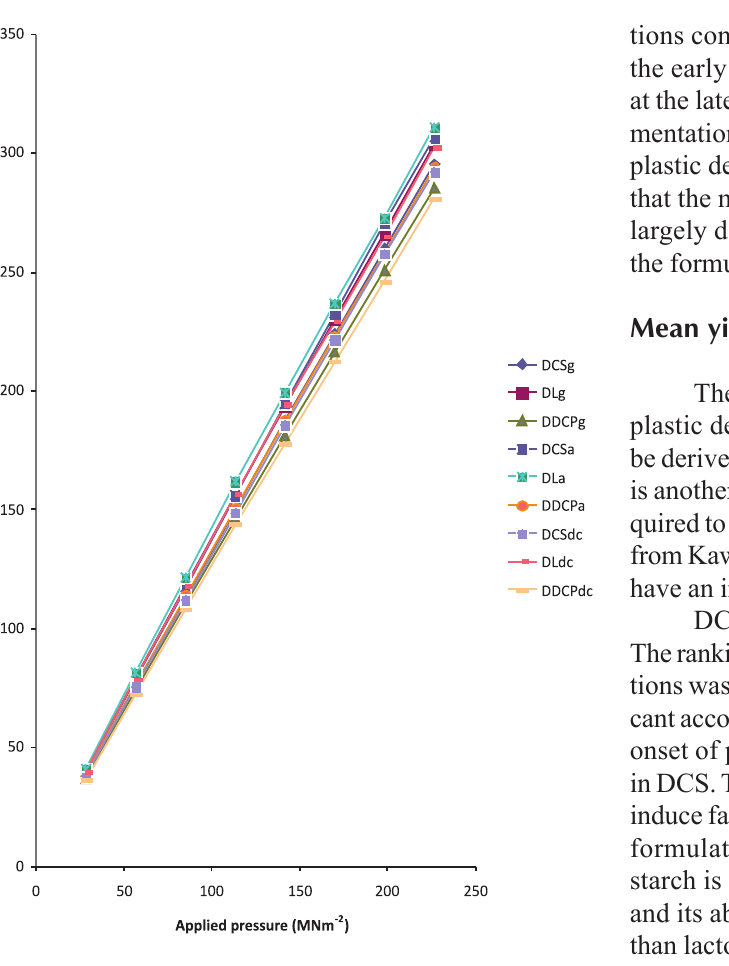
FIGURE 2 - Kawakita plots for Diclofenac TABLE II - Values of relative density of tablets at compression pressure of 113.23MNm -2 (D), P Formulation